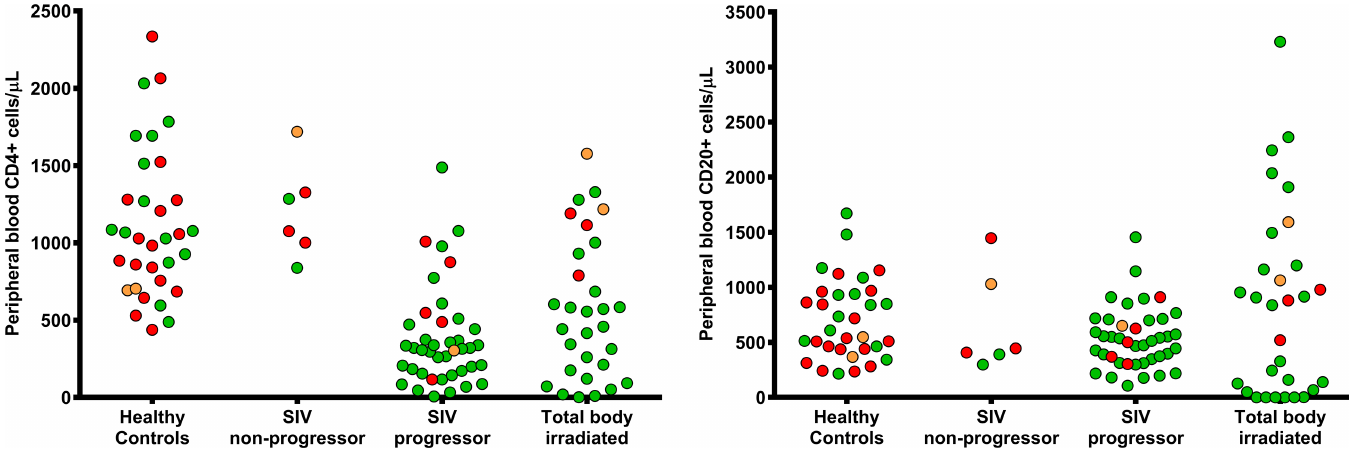
Fig 2. Immunocompetence vs. peripheral blood CD4+ and CD20+ cell counts. Peripheral blood (PB) CD4+ cell counts at exposure, but not CD20+ cell counts, were significantly and positivelyassociatedwith odds of development of primary antibody responses (P < 0.001). Plots show PB CD4+ and CD20+ cell counts at exposure, and the outcome of the exposurewhere green dot indicateno immune response, orangedot indicate low neutralizingprimary antibody response, and red dot indicatehigh neutralizingprimary antibody response.